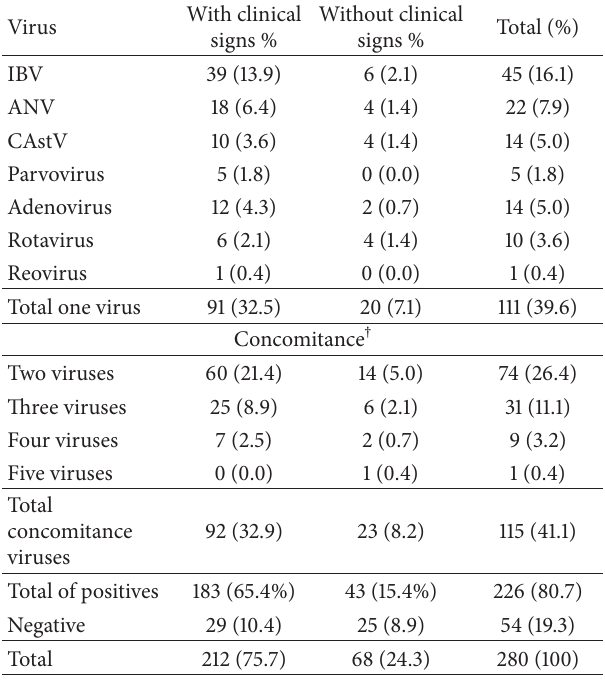
Table 2: Distribution of the seven viruses in the 280 samples of intestinal contents from the chickens with and without clinical signs of enteric diseases from 2007 to